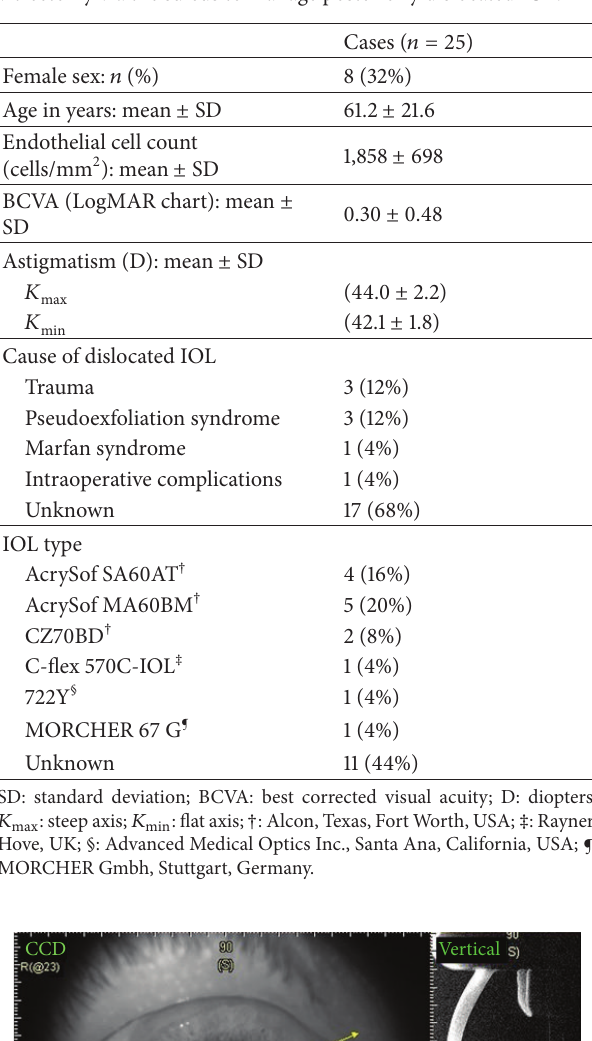
Table 1: Baseline characteristics of patients undergoing 23-gauge vitrectomy via the sulcus to manage posteriorly dislocated IOL.